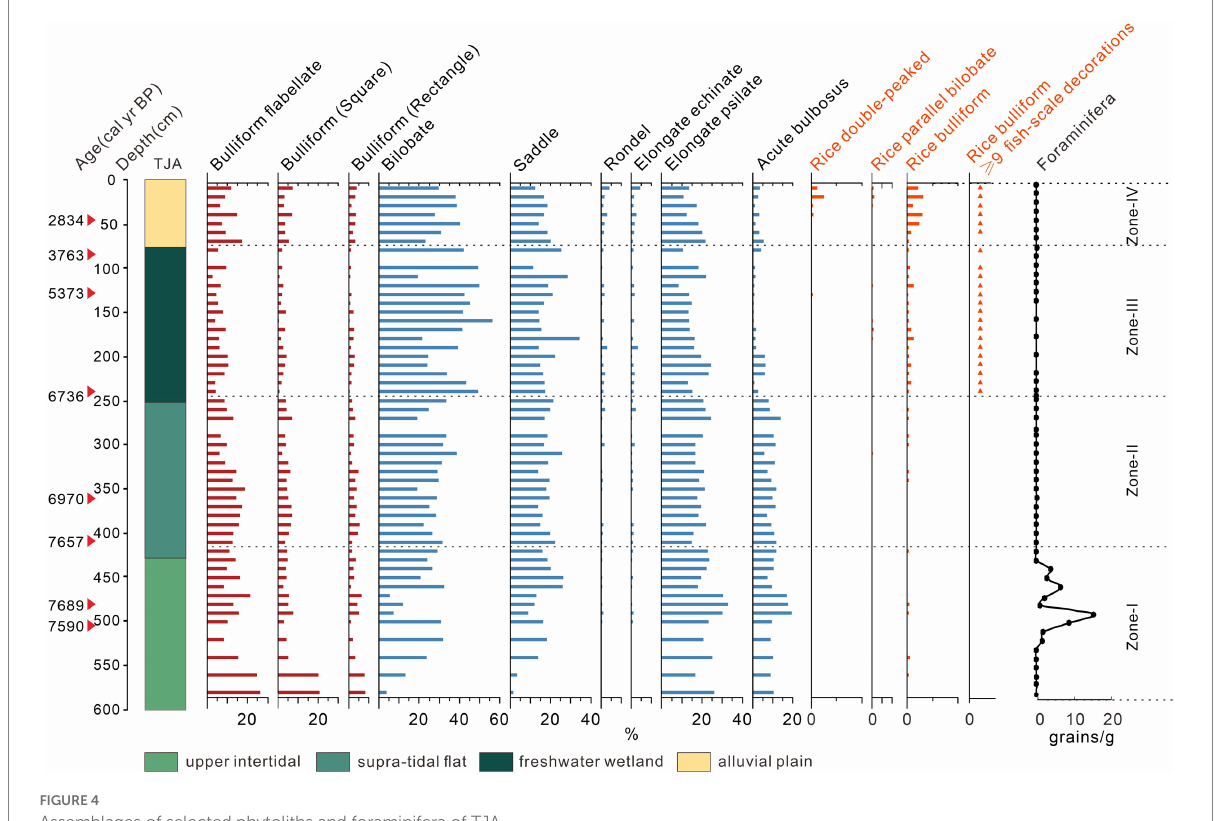
FIGURE 4 Assemblages of selected phytoliths and foraminifera of